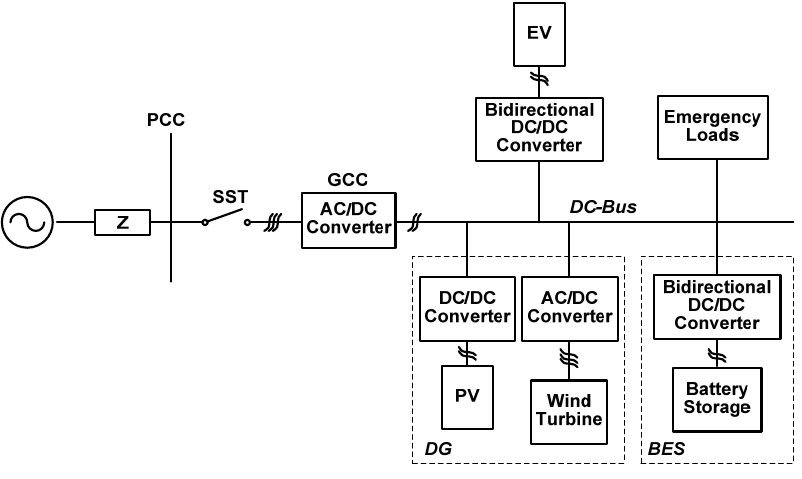
Figure 1. System structure of